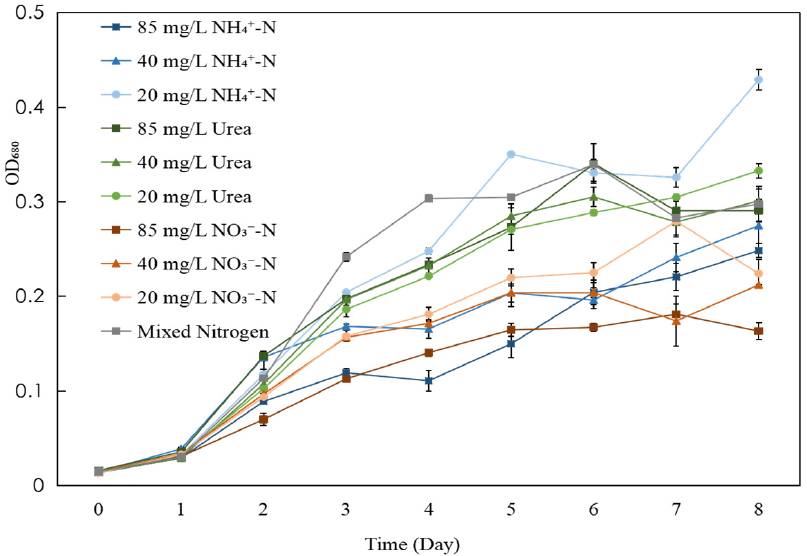
Figure 1. Growth curves of Scenedesmus dimorphus under different forms and concentrations of nitrogen sources in synthetic wastewater ( n = 3).